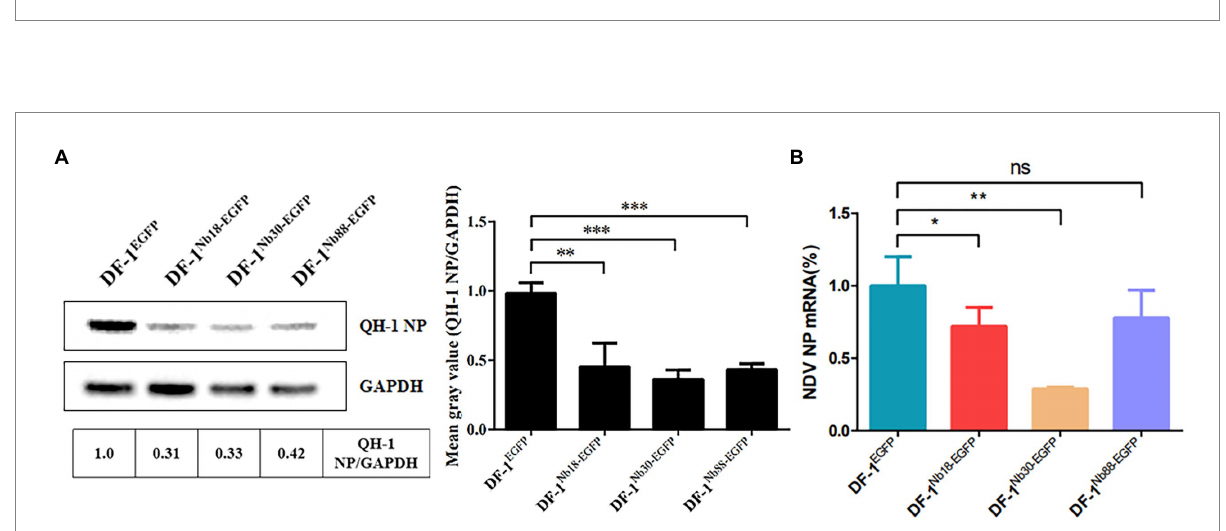
FIGURE 7 Analysis of the four recombinant DF1 cell lines inhibiting replications of Class I NDV strains (QH-1). (A) Detection of NDV NP proteins in the four recombinant DF1 cell lines inoculated with NDV QH-1 strain by Western blotting. (B) Detection of NDV NP mRNAs in the four recombinant cells inoculated with the QH-1 strain via RT-qPCR assay. The results were performed in triplicate and data are presented as the mean ± SD. * p < 0.05; ** p < 0.01; *** p < 0.005 (two-tailed Student t